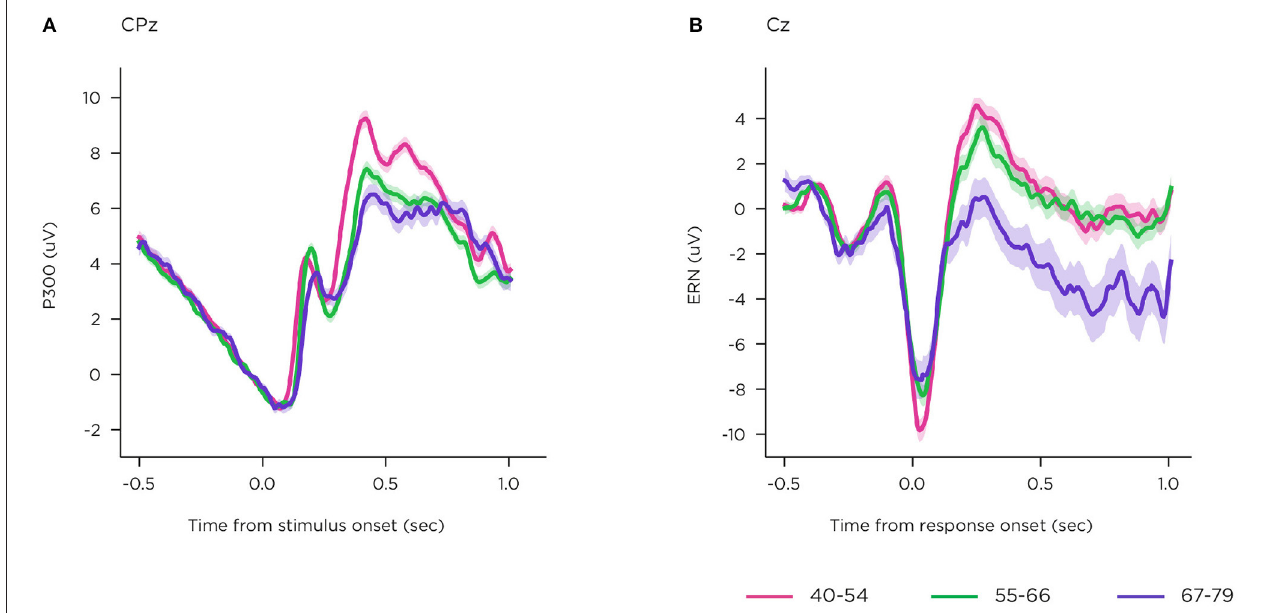
FIGURE 10 | Showing age-related differences in event-related components recorded using the platform. (A) P300; (B)